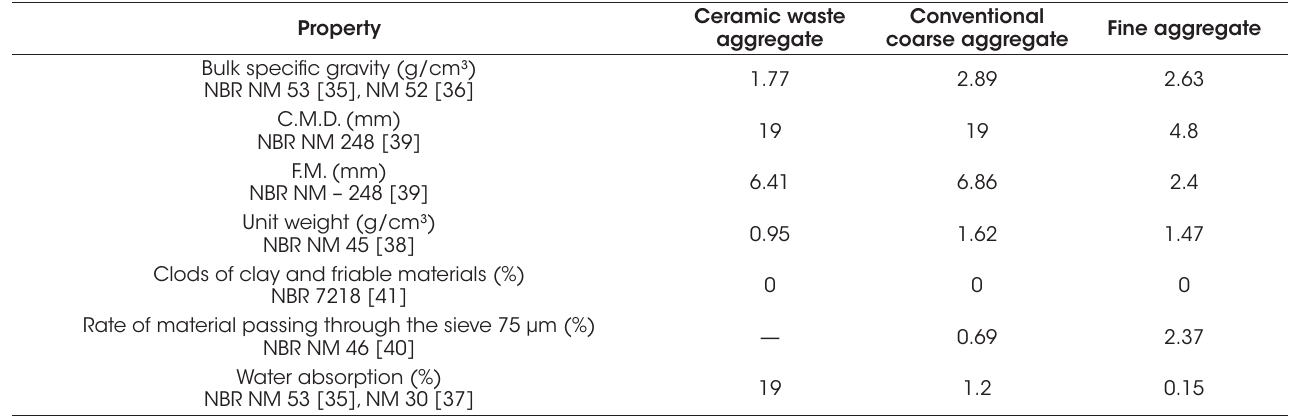
Physical properties of the materials used